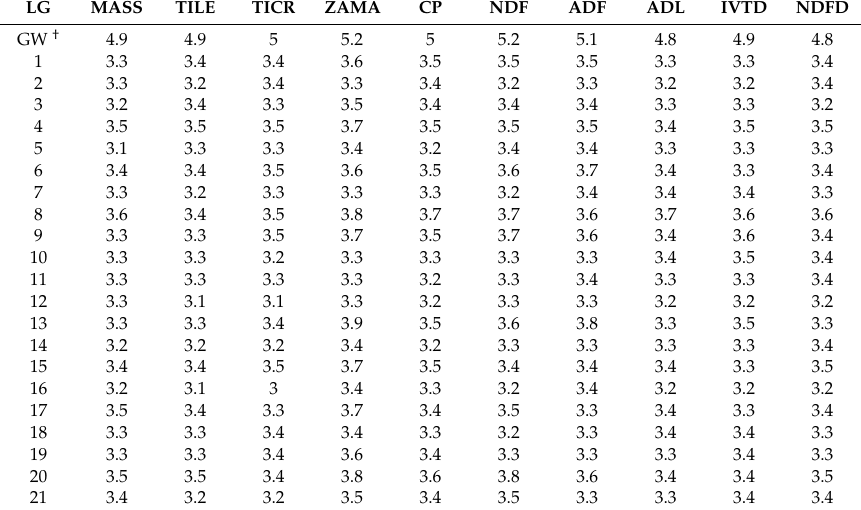
Table A2. The LOD threshold ( p = 0.05) for identifying QTL within each linkage group and at the genome-wide level for 192 clonally replicated, full-sib progeny genets of the M26 × M35 intermediate wheatgrass mapping population evaluated over two years (2016–2017) in three competition environments spaced-plants, polyculture, and monoculture at Logan, UT, USA.